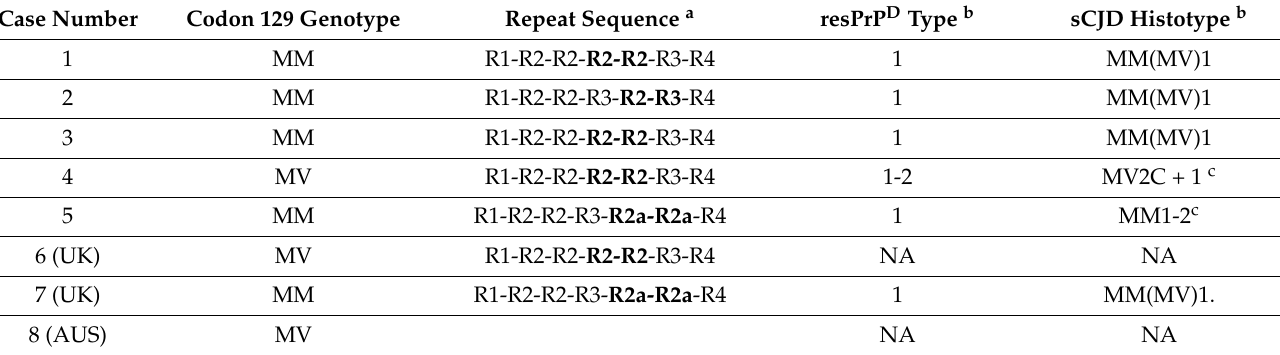
Table 2. Molecular features and histotype of 2-OPRI